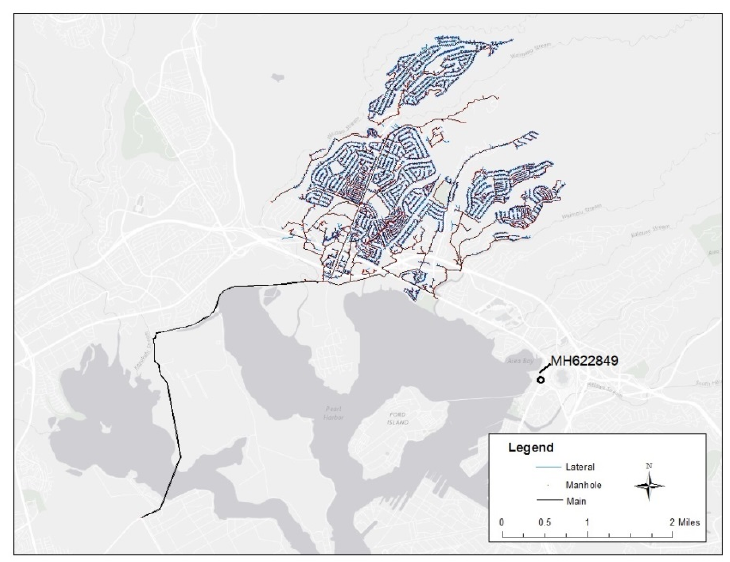
Figure 1. Case study area assessed for sensitivity analysis input parameters (Pearl City, HI).